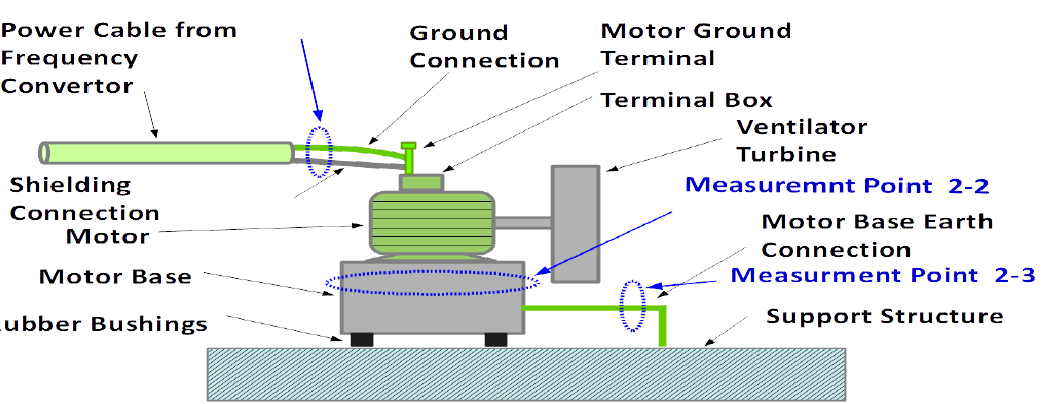
Figure 3. Components related to the fan motor in the ventilation unit and earth connection.